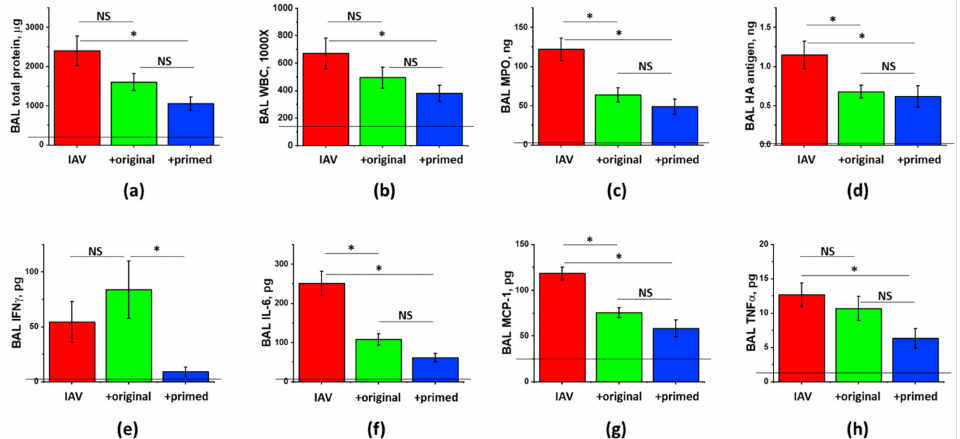
Figure 6. Immune priming of ASC improves ASC-CM ability to limit hyperpermeability and in- flammation in IAV-infected mice. Male C57Bl/6 mice received intranasal administration of IAV H1N1 PR8 (800 pfu/mouse) on Day 0. On Day6 and 8, IAV mice were sub-cutaneously injected with 2.25 mg/kg of the original (green columns) or primed (blue columns) ASC-CS or an equivalent volume of PBS (red columns). BAL fluids were collected on Day9 to analyze for total protein levels ( a ), white blood cell counts ( b ), myeloperoxidase ( c ) and PR8 hemagglutinase levels ( d ), and IFN γ ( e ), IL-6 ( f ), MCP-1 ( g ) and TNF α ( h ) levels. n = 4–6 per group, presented are mean +/ − SEM. Lines indicate levels of analytes detected in control (saline to lung) mice. * for p < 0.05 by t -test with Welch correction (unequal variances) between groups indicated. NS - differences between the groups are not